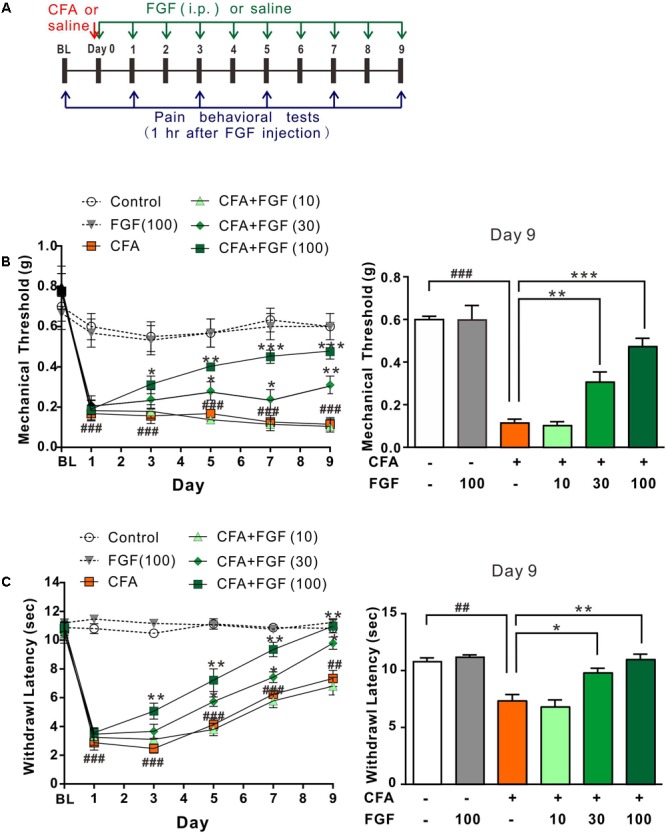
FGF reversed CFA-induced mechanical allodynia and thermal hyperalgesia in a dose-dependent manner. (A) The diagram of the experimental timeline. The baseline (BL) threshold was measured at the day before any treatment. On day 0, CFA emulsion or saline was injected into the intradermal region of the left hind paw. Mice then received intraperitoneal (i.p.) FGF or saline injections daily until day 9; the first FGF treatment was applied 1 h after the CFA injection on day 0. Pain behavioral tests were performed 1 hr after FGF treatment. Effects of different doses of FGF (10, 30, or 100 mg/kg) on the mechanical threshold and the withdrawal latency were shown in (B) and (C), respectively. Two-way ANOVA and Bonferroni multiple comparison tests as post hoc analyses were used (n = 7–9 mice per group). ##, ### vs. controls and ∗, ∗∗, ∗∗∗ vs. CFA-treated animals. One symbol, p < 0.05; two symbols, p < 0.01; three symbols, p < 0.001.